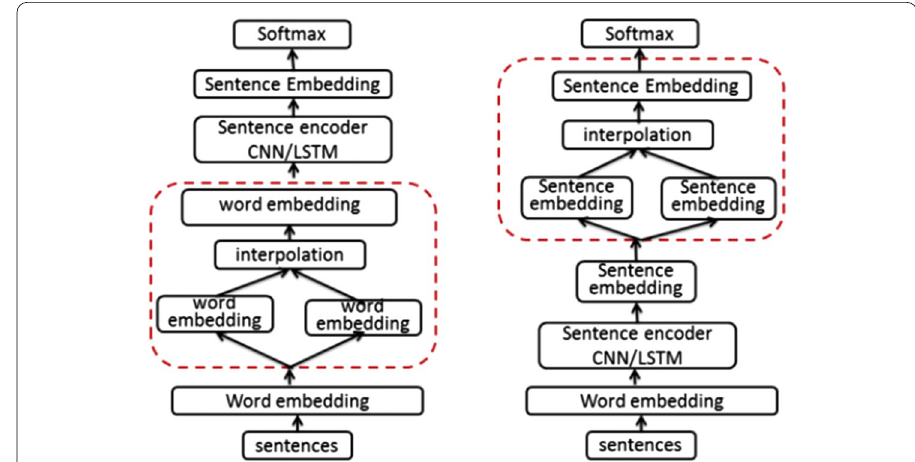
Fig. 3 Left, word-level mixup. Right, sentence-level mixup. The red outline highlights where augmentation occurs in the processing